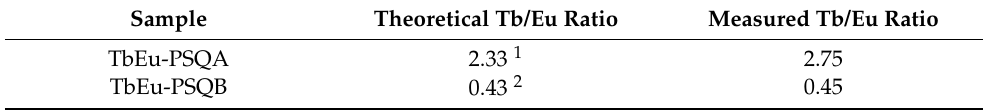
Table 1. Tb 3+ /Eu 3+ ratio in TbEu-PSQA and TbEu-PSQB solids obtained by EDX analyses.